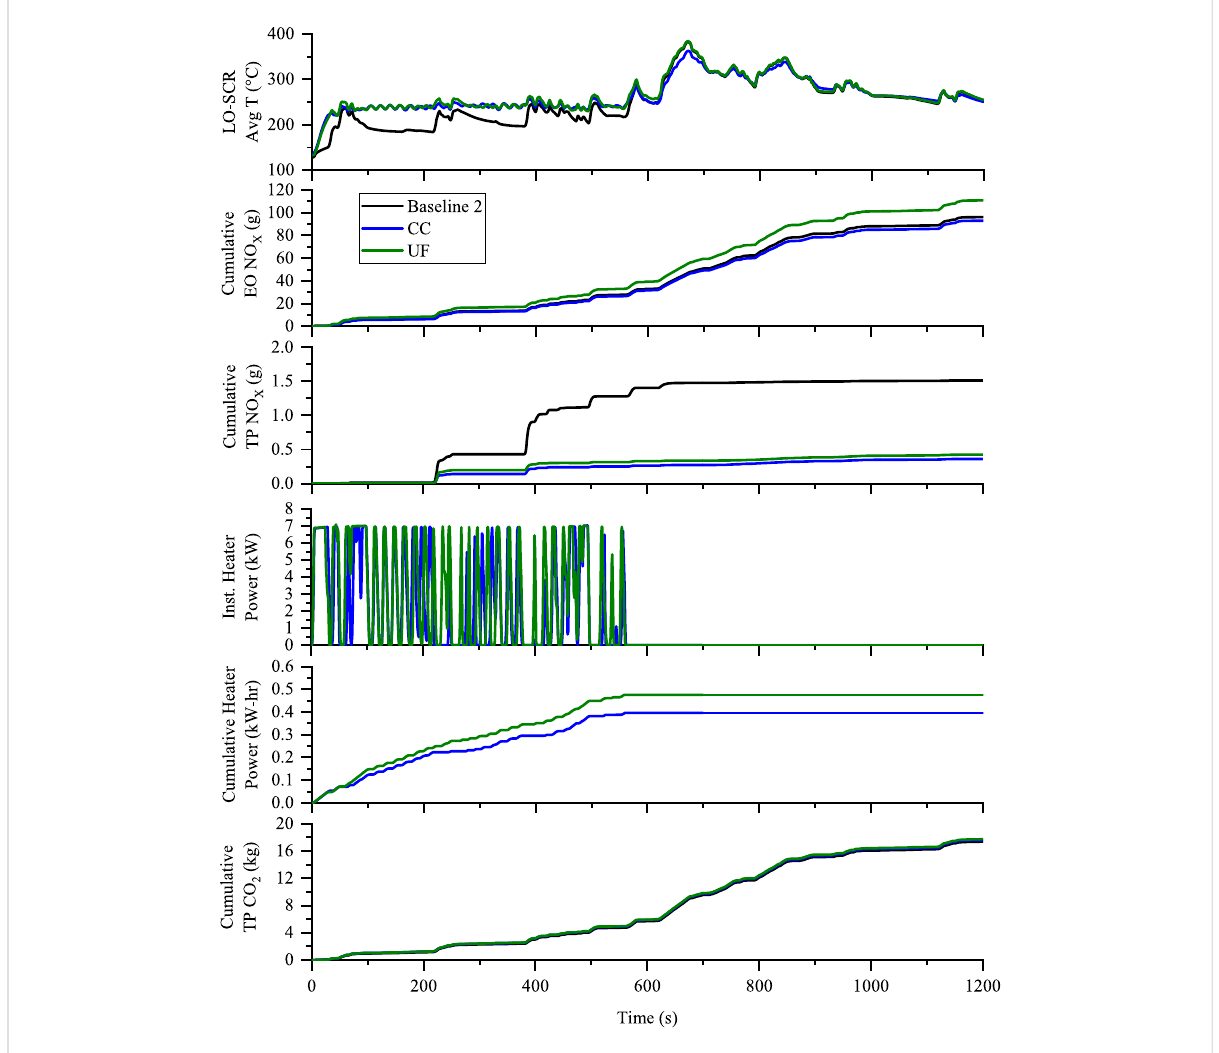
FIGURE 7 Comparison of the CC LO-SCR and UF LO-SCR to Baseline 2 on a Hot FTP cycle for the LO-SCR average temperature, emissions, and heater electrical power